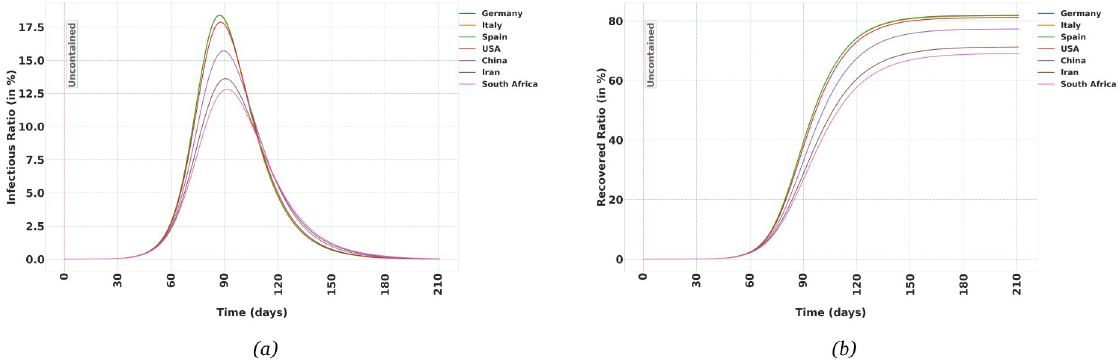
Fig 5. (a) The uncontained scenario in different countries assuming SARS-CoV-2 dynamics follow a SIR model, not a SEIR model, (a) Aggregate ratio of Infectious compartment, (b) Aggregate ratio of Recovered